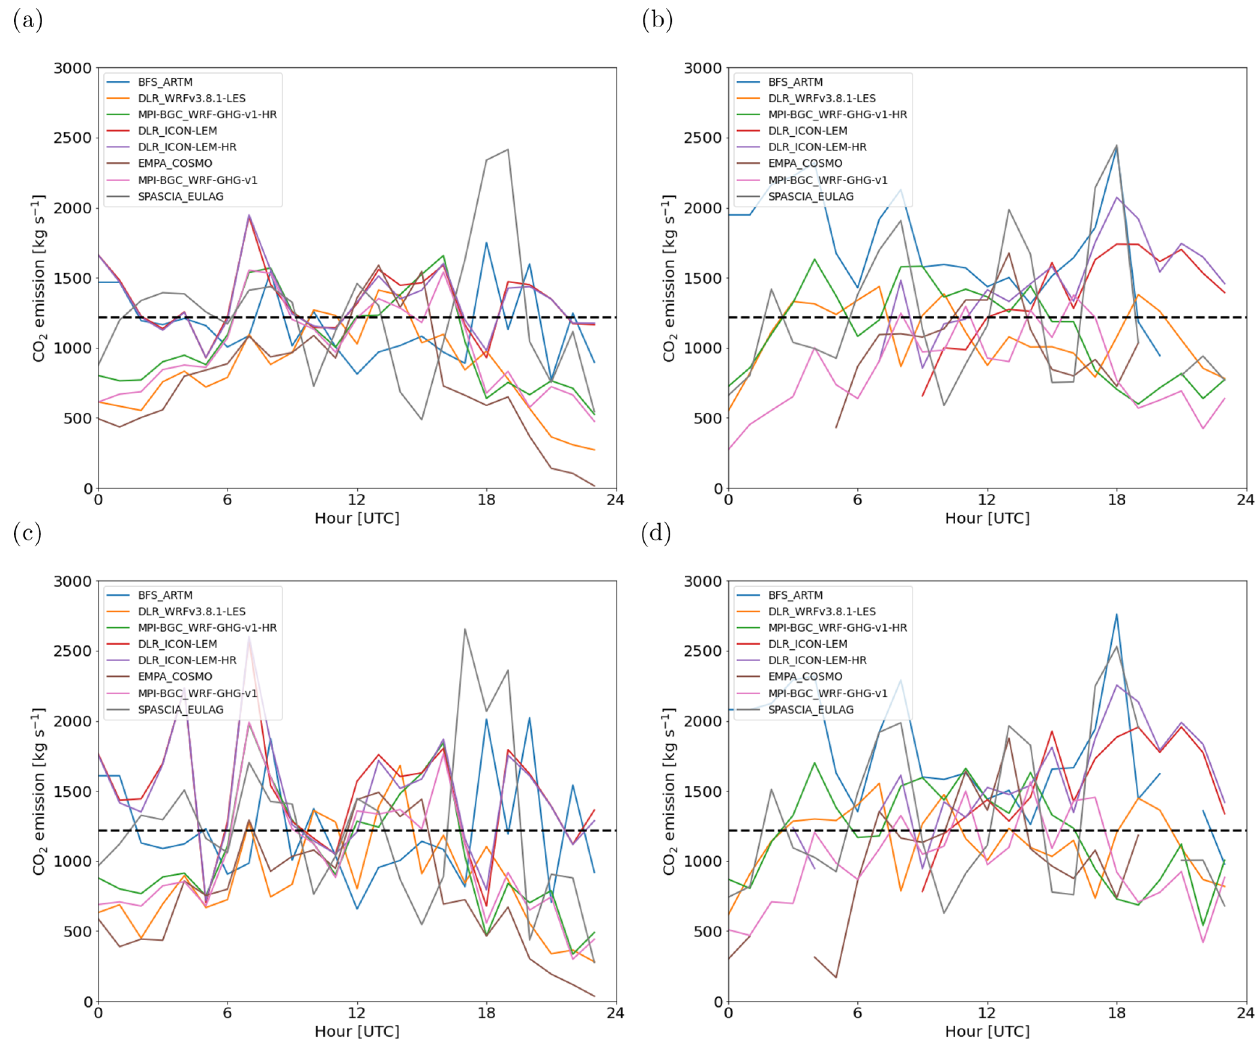
Figure 15. Emissions quantified for the Bełchatów plume for all hours of 7 June 2018 by the (a, c) cross-sectional flux method and (b, d) in- tegrated mass enhancement method. (a, b) Low-noise CO2M scenario (0.5ppm) and (c, d) high-noise scenario (1.0ppm). The dashed line shows the true emissions. Effective wind speeds were obtained as vertically averaged wind speed between 925 and 875hPa (see text for further